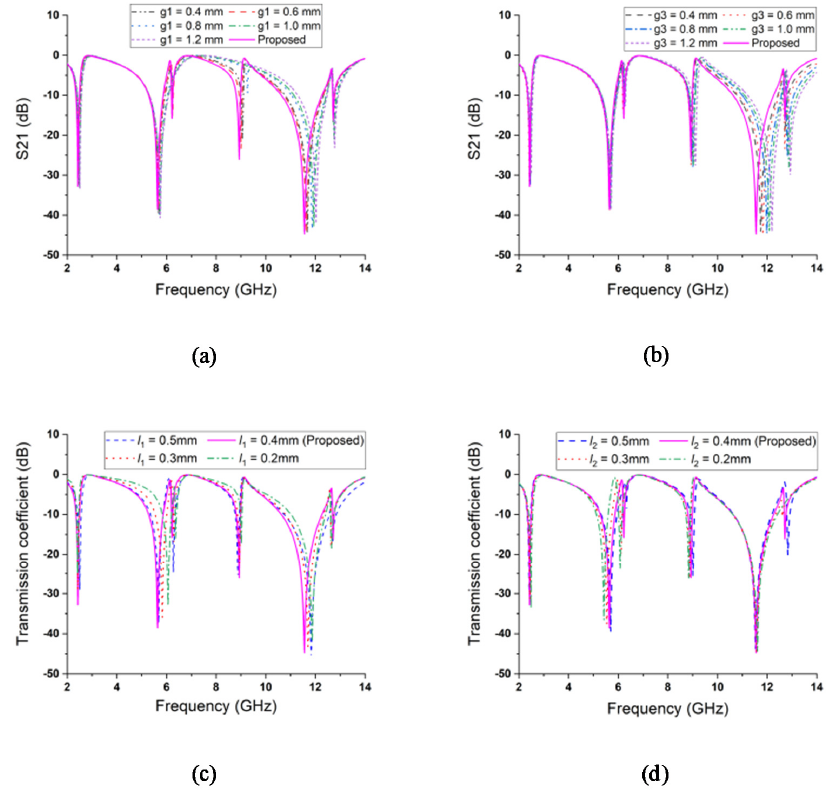
Figure 7. S21 of the proposed metamaterial unit cell based on the ( a ) split gap variation of g1; ( b ) split gap variation of g3; ( c ) length variation of l1; ( d ) length variation of l2.